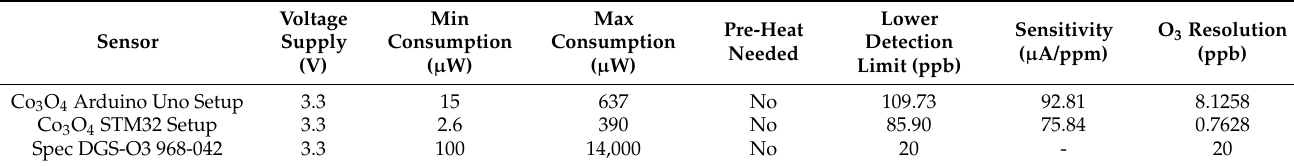
Table 3. Specifications of MCU-based